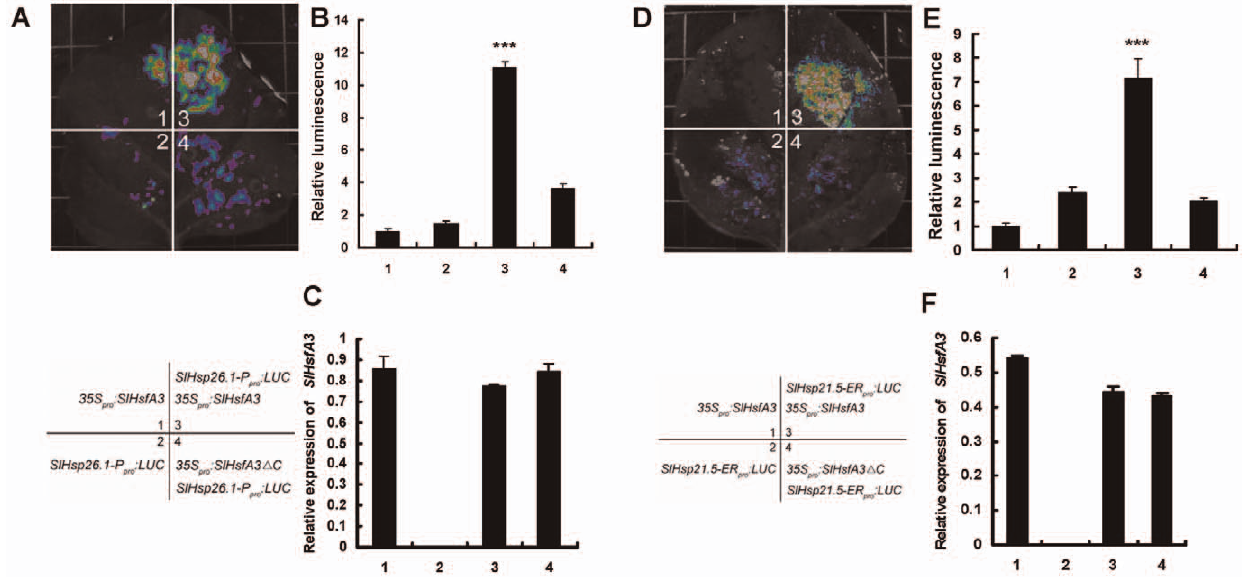
Figure 9. SlHsfA3 activates SlHsp26.1-P and SlHsp21.5-ER expression as revealed by transient assays of N.benthamiana leaves. (A) Transient expression assays showing that SlHsfA3 activates the expression of SlHsp26.1-P . Representative images of N. benthamiana leaves 72 h after infiltration are shown. The bottom panel indicates the infiltrated constructs and treatments. (B) Quantitative analysis of luminescence intensity in (A). Five independent determinations were assessed. Error bars represent SD. Asterisks denote Student’s t test significance compared with control plants: ***P , 0.001. (C) qRT-PCR analysis of SlHsfA3 expression in the infiltrated leaf areas shown in (A). Total RNAs were extracted from leaves of N. benthamiana coinfiltrated with the constructs. Five independent determinations were assessed. Error bars represent SD. (D–F) Transient expression assays showing that SlHsfA3 activates the expression of SlHsp21.5-ER . Experiment procedures were the same as transient expression assays for SlHsp26.1-P .